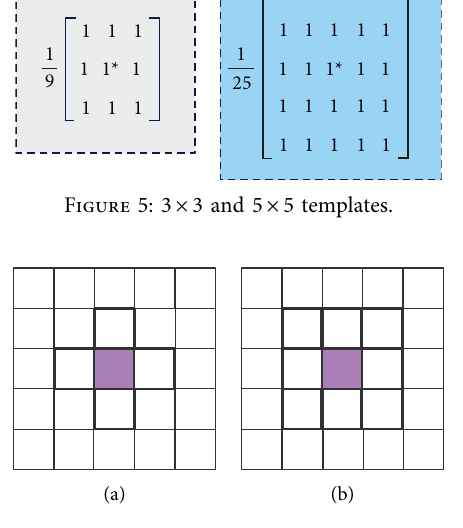
Figure 6: Four-neighborhood (a). Eight-neighborhood